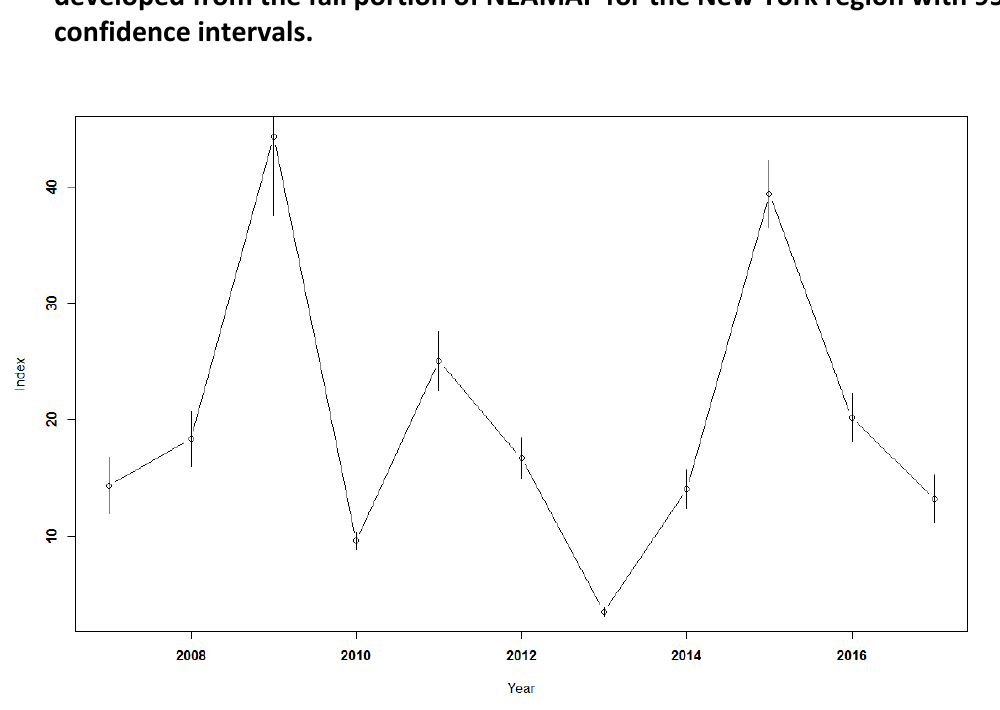
Figure 41. Index of relative abundance of horseshoe crab (delta mean catch per tow) developed from the fall portion of NEAMAP for the Delaware Bay region with 95% confidence